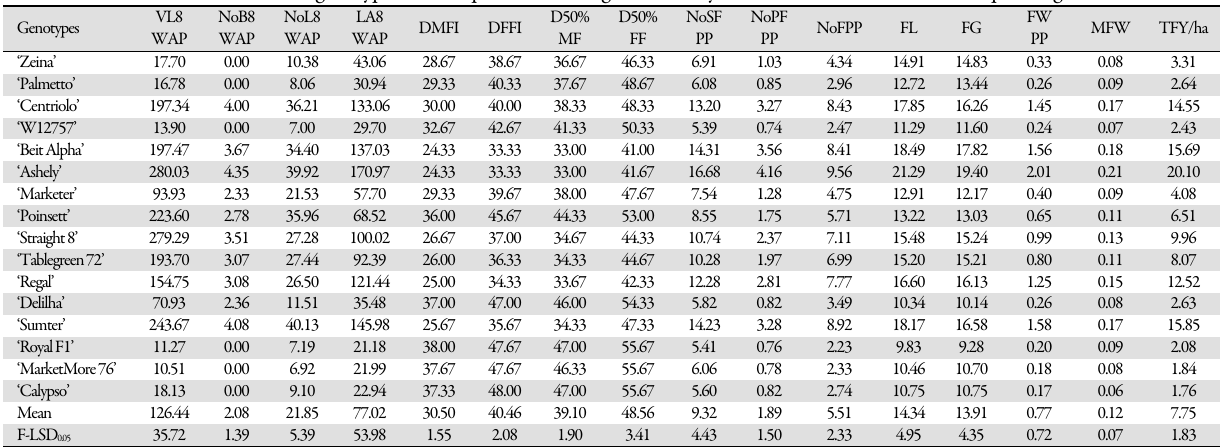
Table 4. Performance of cucumber genotypes with respect to some vegetative and yield traits evaluated in 2014 late planting season VL8 Genotypes WAP ‘Zeina’